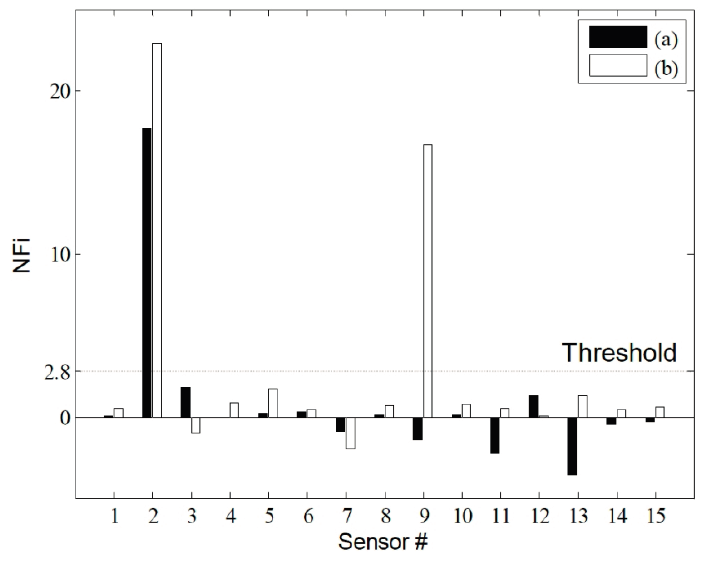
Figure 12. Damage localization based on the normalized outlier index: ( a ) DC1 from IC and ( b ) DC2 from